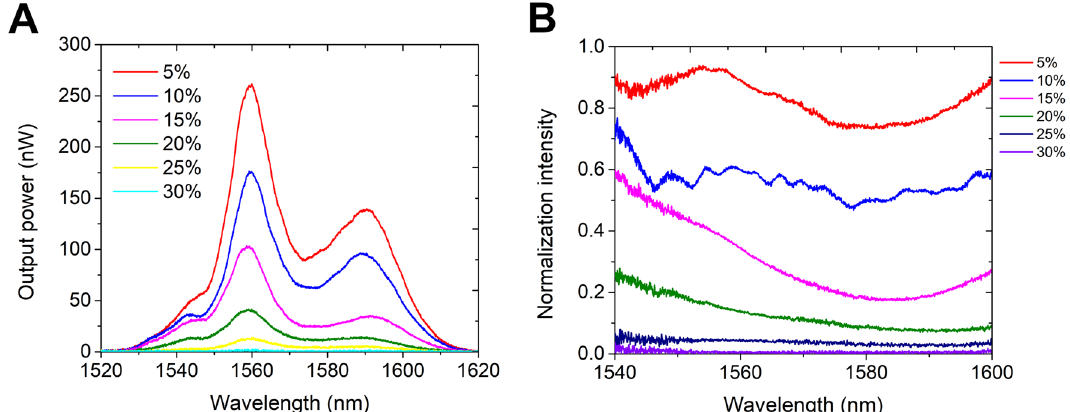
Figure 4. ( A ) Optical spectra of AuNPs decorated TOF ( Ø = 12 μm diameter) sensor in different mass fractions of glucose solutions and ( B ) Corresponding normalized intensity spectra.